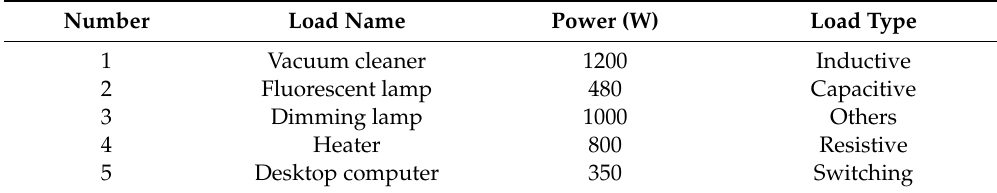
Table 2. Typical